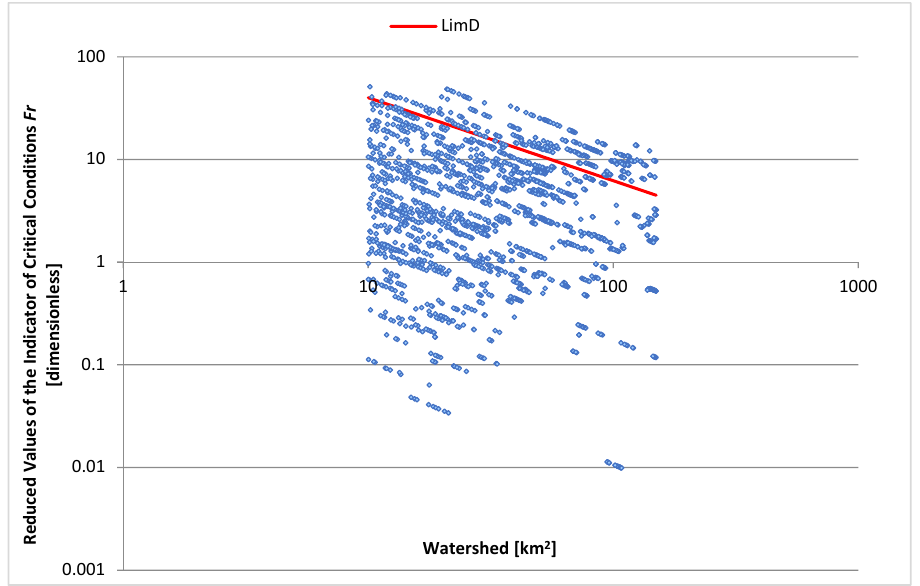
Figure 6. Reduced values of the indicator of critical conditions F r depending on the size of the watershed within the group of watersheds 201-202-203.